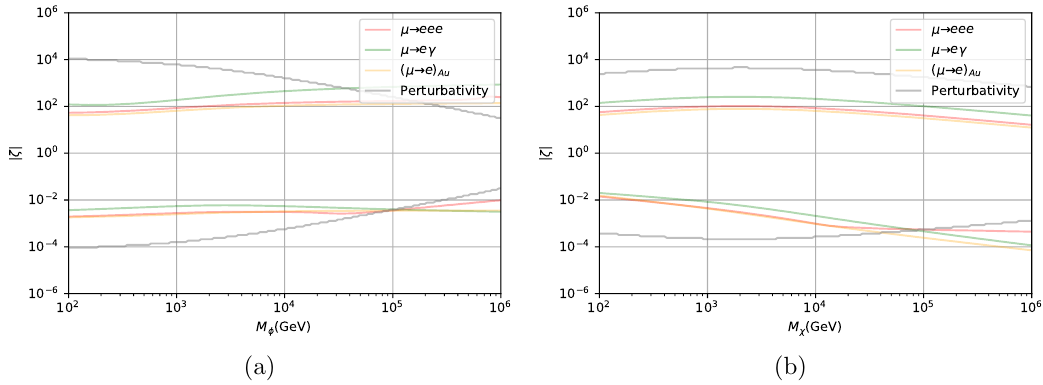
Figure 7. Regime 2 . Constraints on (cid:16) for varied singlet (cid:30) LQ mass (a), and vector-like quark mass (b); in each case the alternate mass is (cid:12)xed at 2 TeV and the isotriplet LQ couplings are switched o(cid:11). Allowed points for each constraint lie between the two same-coloured lines.